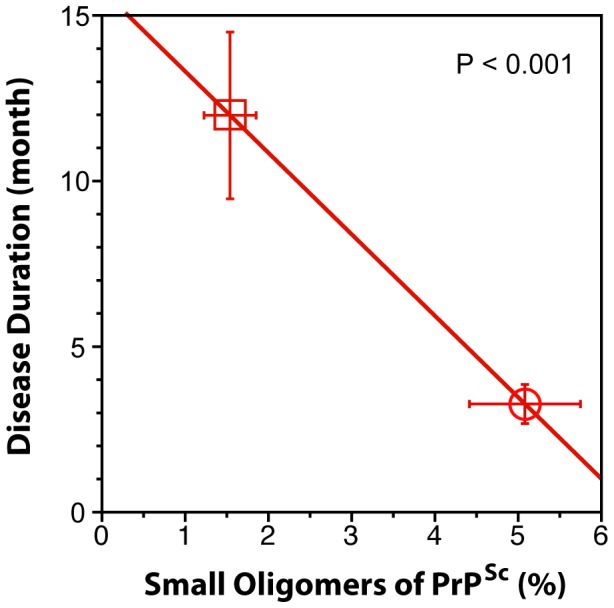
The inverse relationship between proportion of small oligomers of PrPSc and duration of sCJD.The levels of small oligomers of PrPSc with the highest seeding potency that eluted at 2.4–3.2 ml of sucrose gradient (
Fig. 5D and Fig. 5E
) were expressed as a percentage of total PrPSc in (circle) MM1 (n = 6) and (square) MM2 (n = 6) sCJD cases. Each symbol represents an average ± SEM.